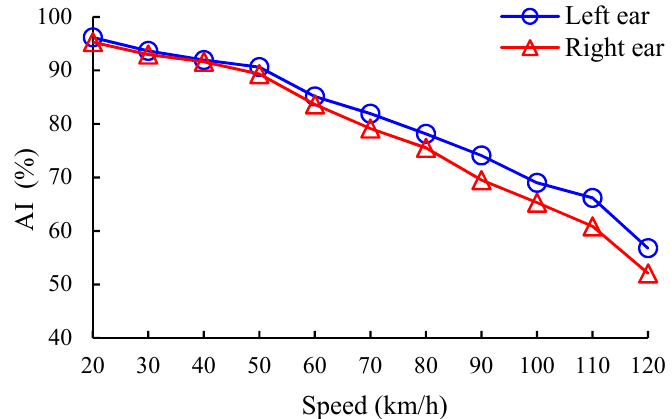
Figure 11. Interior noise articulation index (AI) in the EV as a function of the vehicle’s speed.